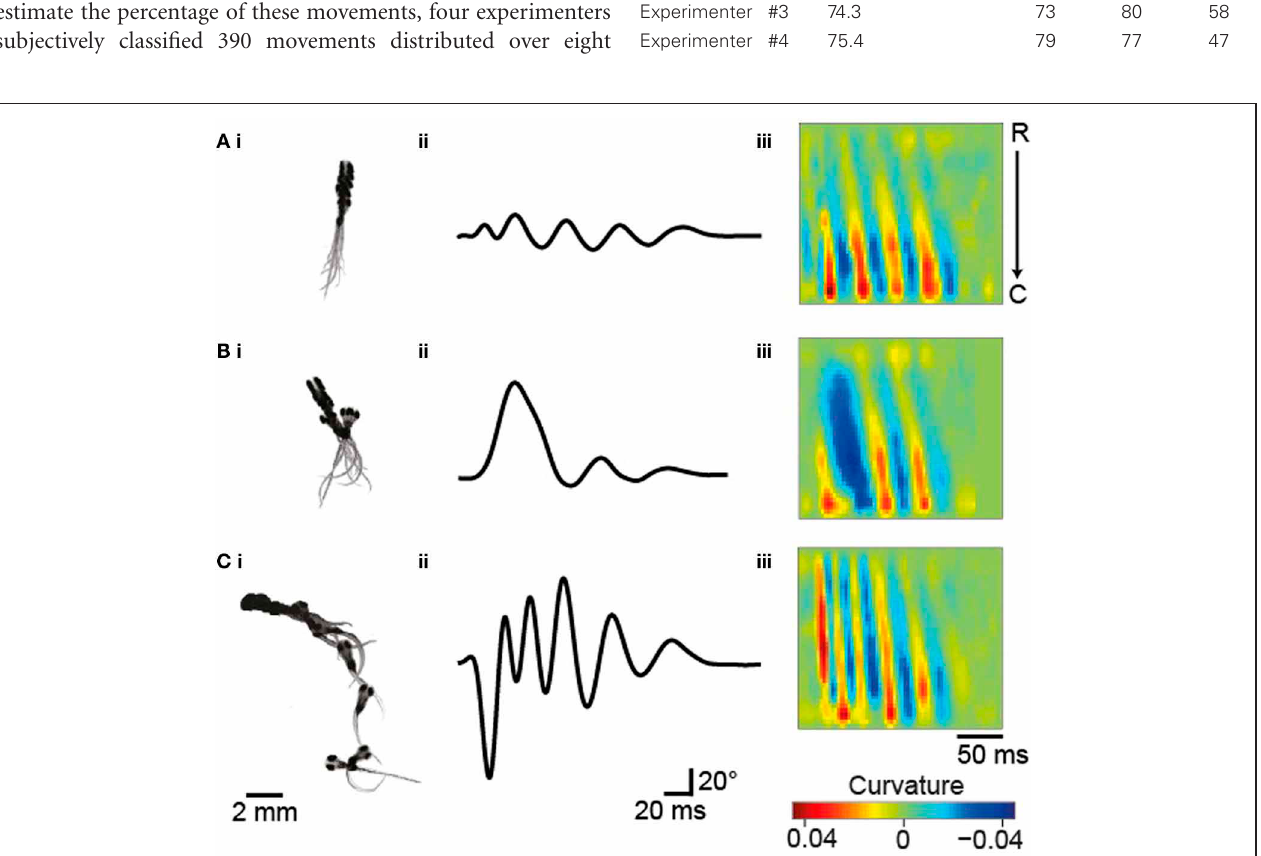
FIGURE 3 | Typical maneuvers occurring in groups of 5–6dpf larvae. (A) Slow forward swim (S). (B) Routine turn (T). (C) Escape response (E). (Ai–Ci) Superimposed images taken every 17ms. (Aii–Cii) The